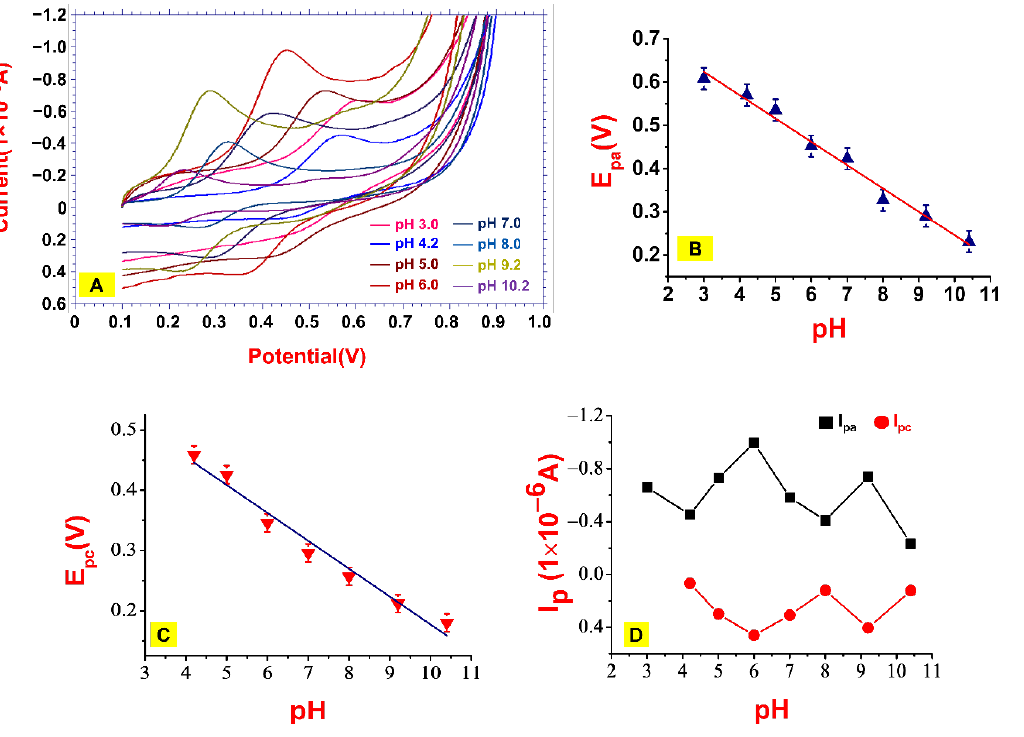
Figure 4. Impact of electrolyte solution. ( A ) Cyclic voltammograms of 0.01 mM ZLT at different pH levels (0.2 M PBS). Effect of pH on ( B ) E pa , ( C ) E pc , and ( D ) peak currents (I pa and I pc ).